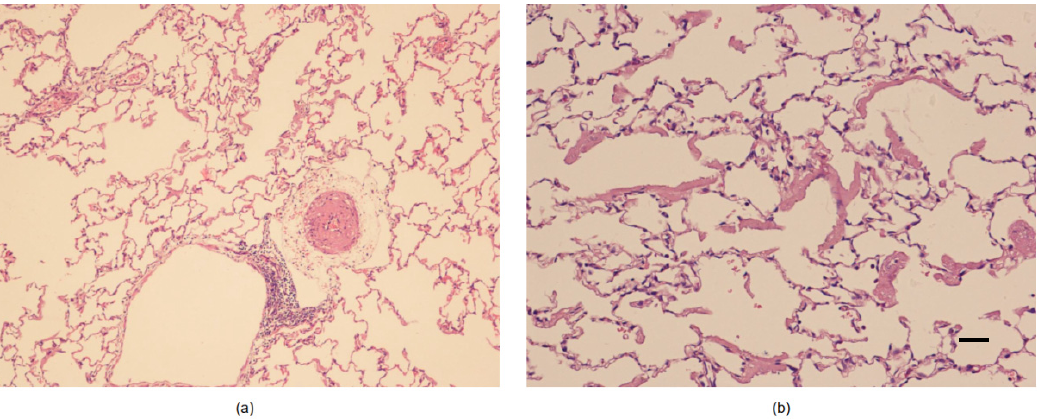
Figure 1. Histological samples from post-mortem biopsies. ( a ) A small artery with evident hypertrophy on the muscular layer is present in the pulmonary interstitium. (Hematoxylin-Eosin 100X original magnification); ( b ) Alveoli show an exudate with hyaline membrane appearance (Hematoxylin-Eosin 200X original magnification; bar indicates 100 μ m).